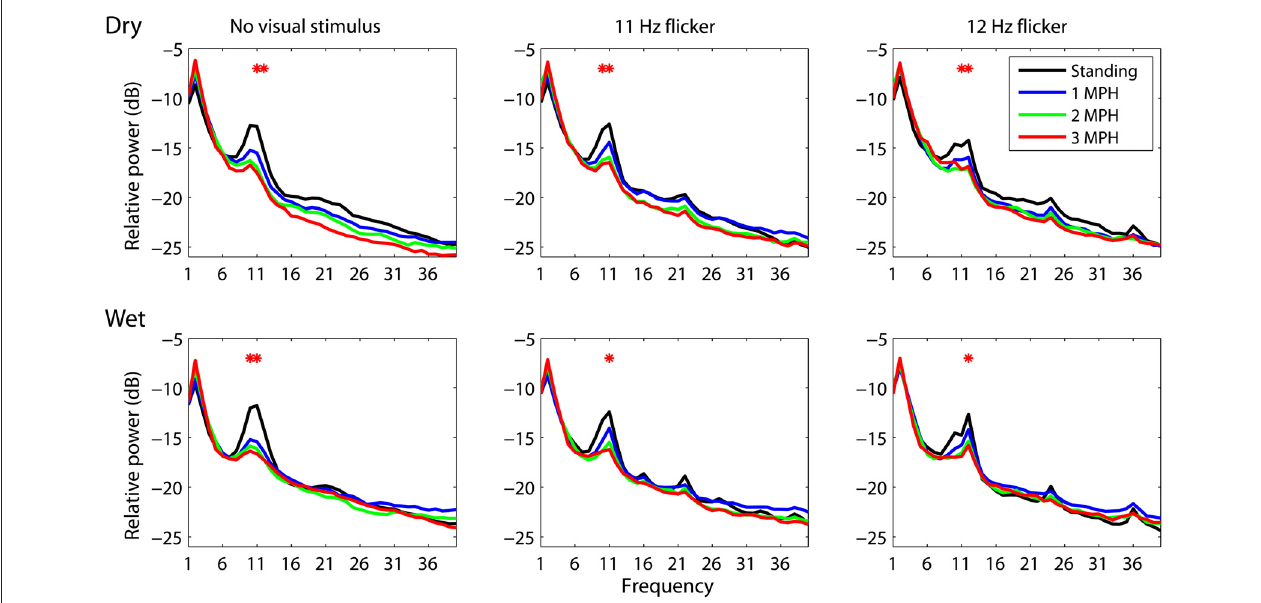
FIGURE 2 | The dry-wet electrode comparison in spectral fluctuations associated with different walking speeds while presenting without/with visual flickers (11 or 12 Hz) . The asterisk indicates the significant difference between speeds ( p <